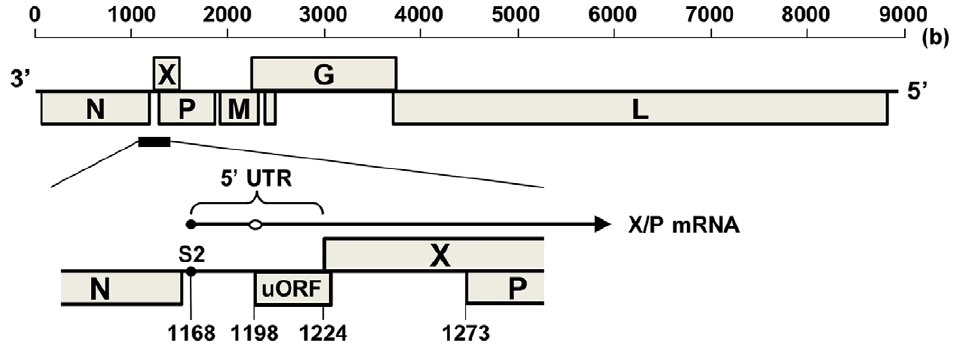
Figure 1. Schematic representation of BDV genome. An illustration of the genome organization of BDV is shown at the top. The genome region corresponding to the 5 9 UTR of X/P mRNA is enlarged in the center. The arrow indicates a schematic structure of X/P mRNA. The open circle on X/P mRNA indicates the region of a predicted stem-loop structure. The regions of transcription start signal for X/P mRNA (S2) and uORF are shown. The number indicates the nucleotide position of the BDV genome (strain huP2br: Accession number AB258389).